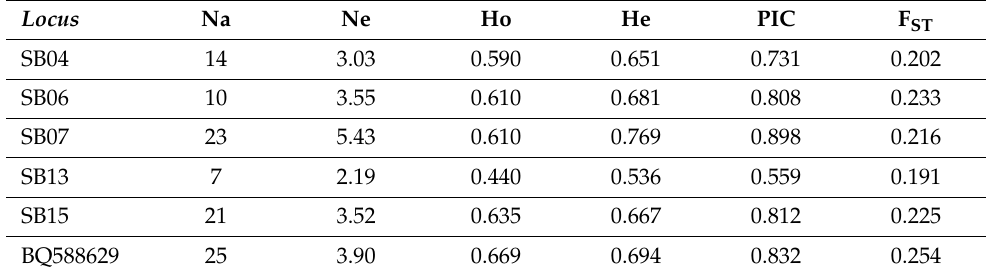
Table 1. SSRs loci used and their genetic diversity measures and F -statistics following Nei (1987) estimated over all wild beet populations for six SSRs loci: Na—number of alleles; Ne—number of effective alleles; Ho—observed heterozygosity; He—expected heterozygosity; PIC—polymorphism information content; F ST —differentiation